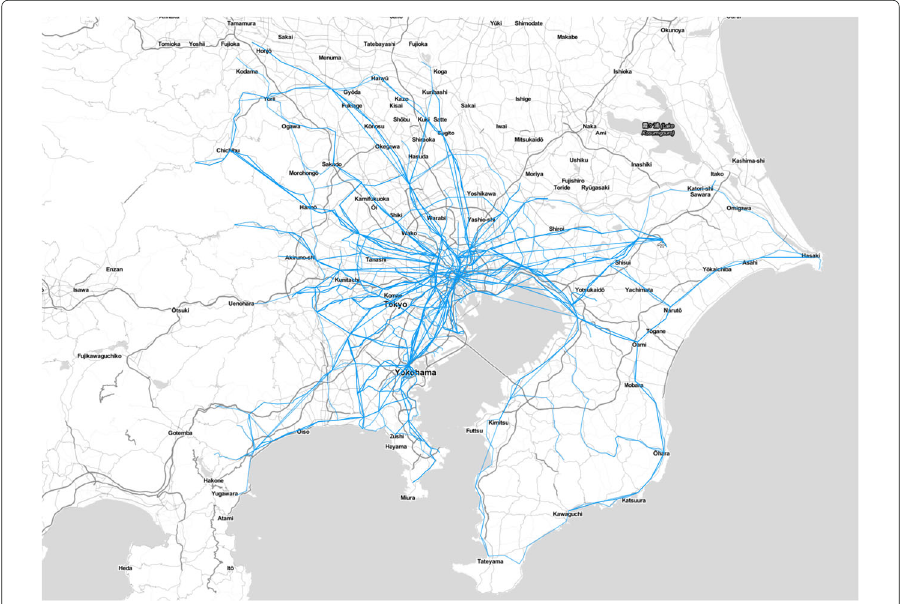
Fig. 4 A map of the Tokyo area showing the edges of the train network. Map tiles by Stamen Design (2019), map data by OpenStreetMap(OpenStreetMap Contributors